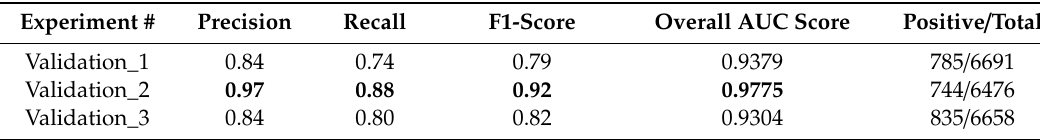
Figure 10. ( a ) Receiver operation characteristic (ROC) curves ( b ) precision–recall curves in three experiment rounds on di ff erent training / validation sets. Table 3. Precision and recall of positive